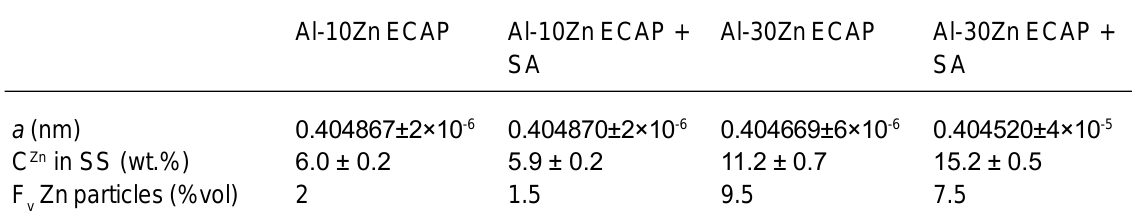
Table 1. Lattice parameter (a) of the fcc Al matrix measured by XRD in the two alloys after ECAP and after ECAP followed by static annealing (SA) of 10min at 200 °C for Al-10Zn and at 250 °C for Al-30Zn. The Zn content in solid solution (C Zn in SS) was estimated using as reference pure Al with a lattice parameter 0.40509 nm and assuming that 1 wt.% Zn decreases this lattice parameter by 0.00375nm [31]. The volume fraction of particle (F ) was estimated from mass balance and assuming that Zn particles do not contain a v significant amount of Al in solid solution. Corresponding XRD profiles are provided in appendix.